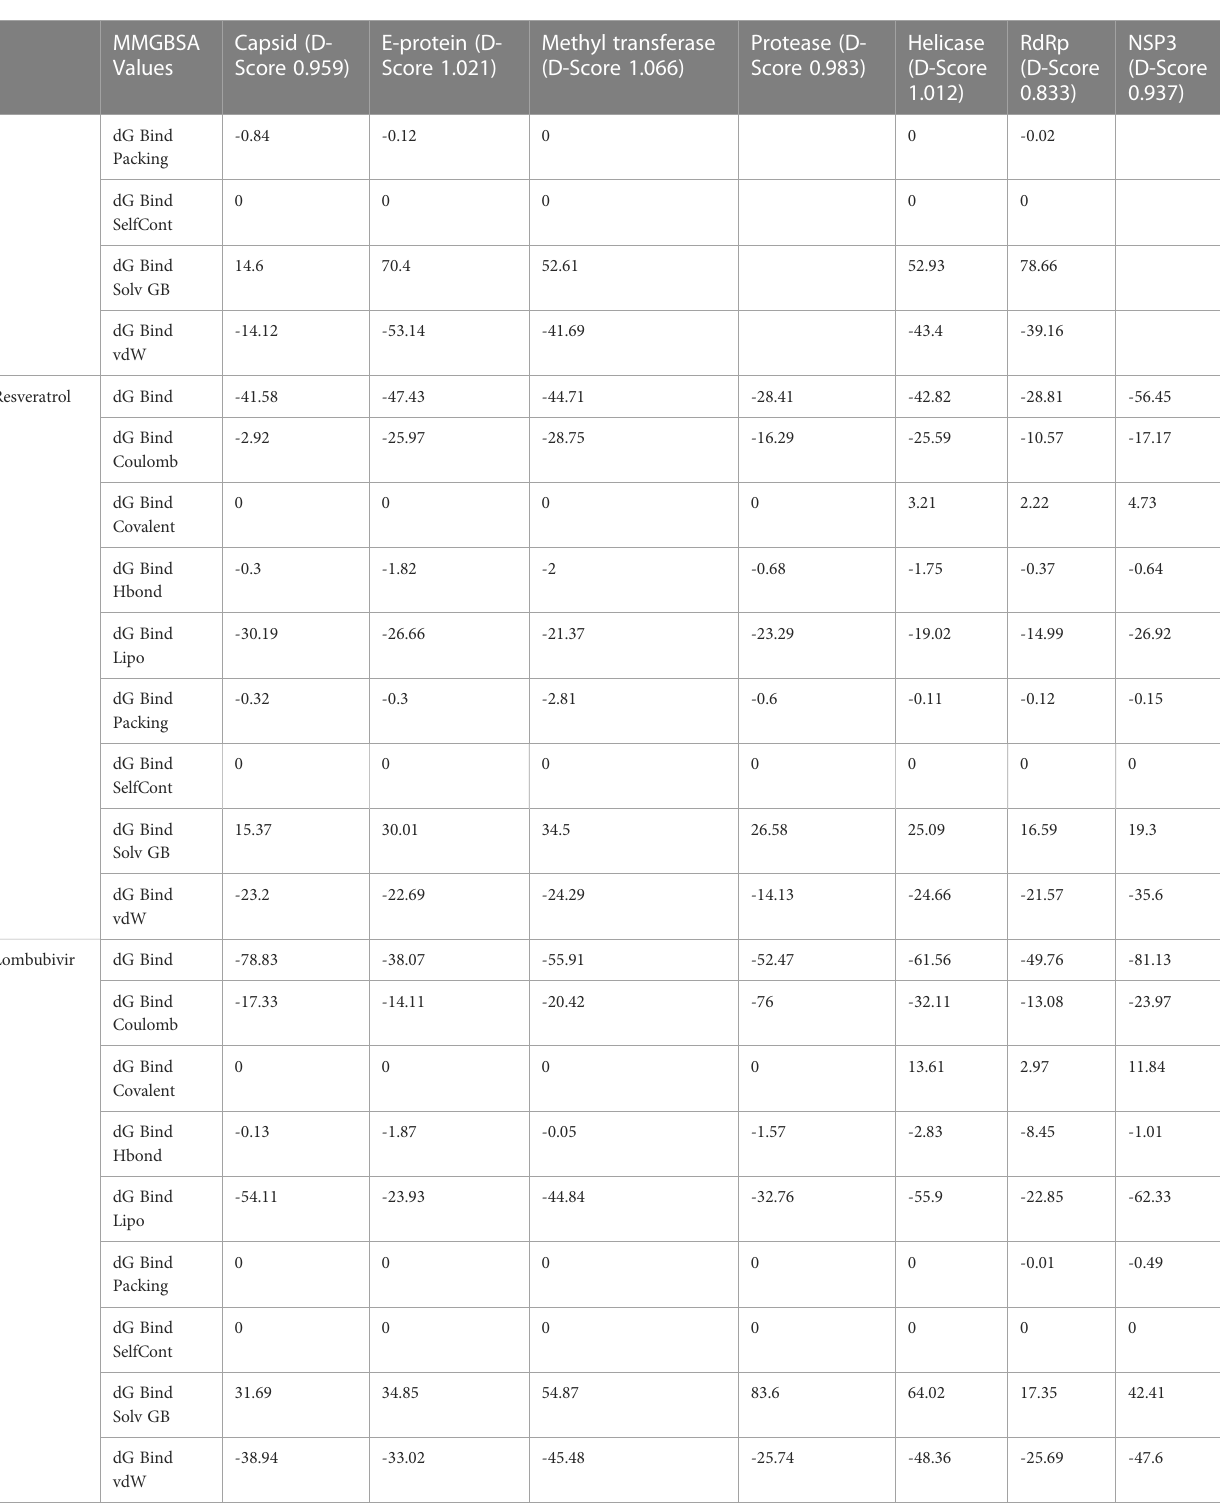
the RdRp and NSP3 macro domain (Table 4). Felbinac formed pi- cation bond with residues arg337, arg319, lys322 and lys325 following pi-alkyl bond with residues arg319, arg340 and arg337. Felbinac showed a binding af fi nity of -39.72 kcal/mol forming strong hydrogen bonds with val113, tyr114 and